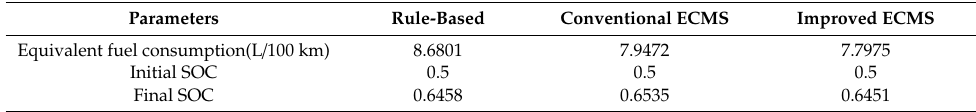
Table 9. Simulation results of fuel